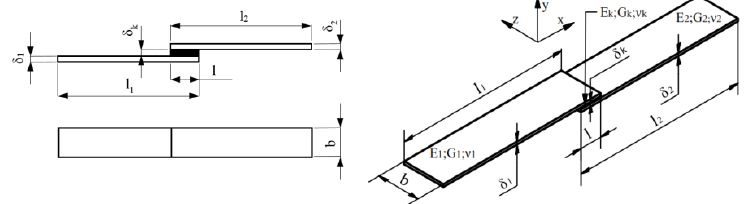
Figure 5. Dimensions in mm of the test specimens for testing the mechanical properties of adherend materials.